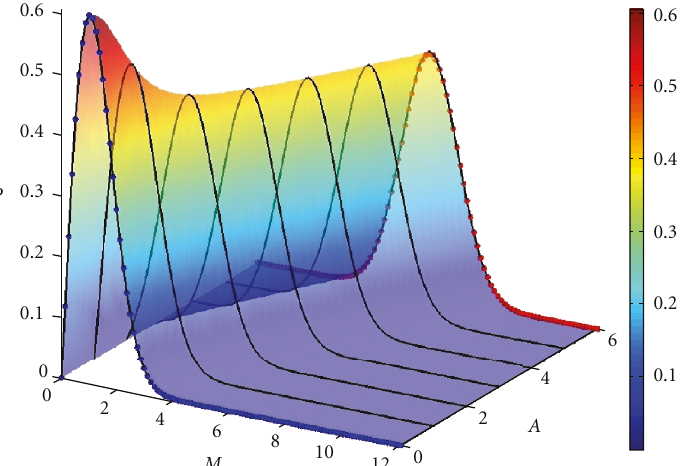
Figure 6: The Rician PDF at various A/σ g ratios (0–6). When A/σ g = 0 the Rician PDF reduces to the Rayleigh distribution (blue dots) however as A/σ g increases to over A/σ > 2 the Rician PDF behaves approximately Gaussian (red dots at A/σ = 6).